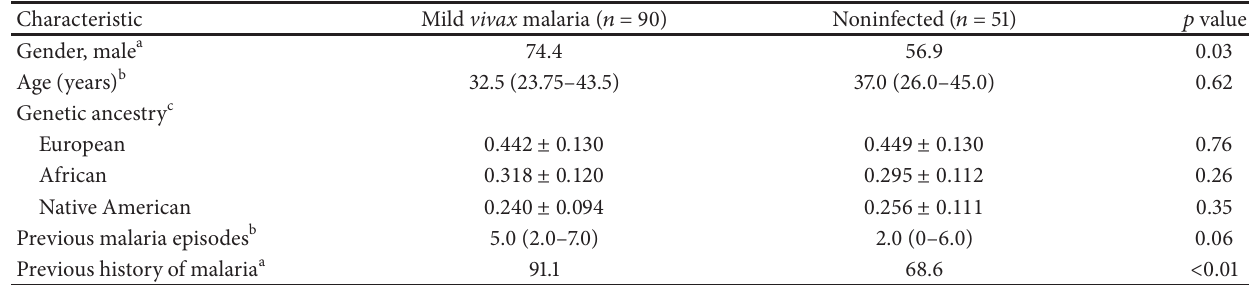
Table 1: Characteristics of the study